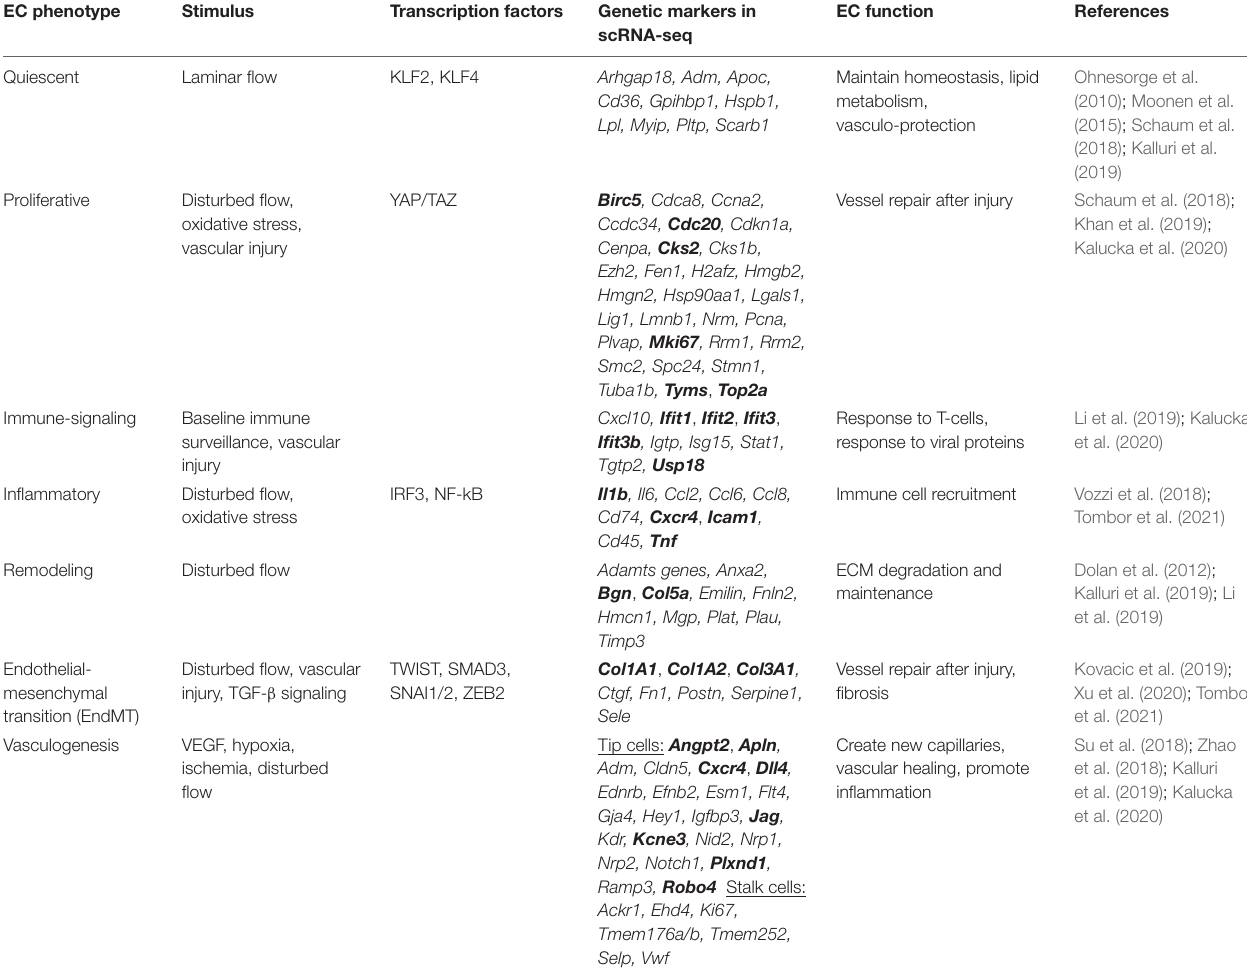
TABLE 1 | Endothelial cell phenotypes identified by transcriptome